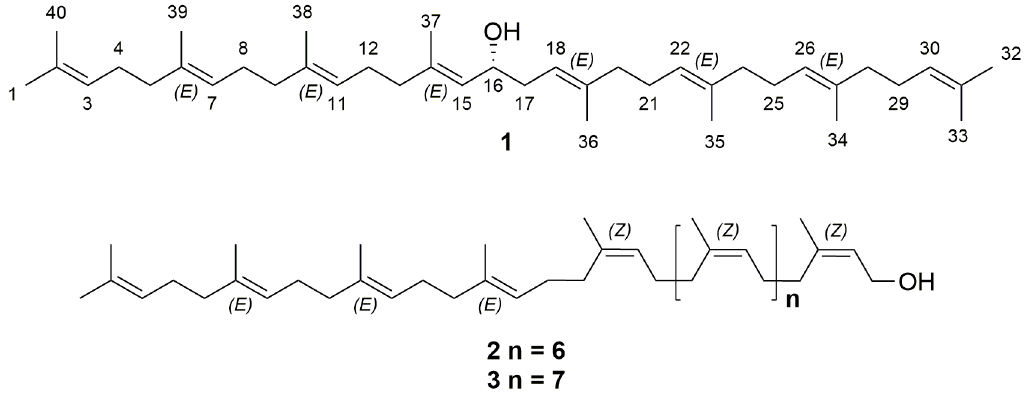
Figure 1. Chemical structures of the polyisoprenoid alcohol Compounds 1 – 3 .